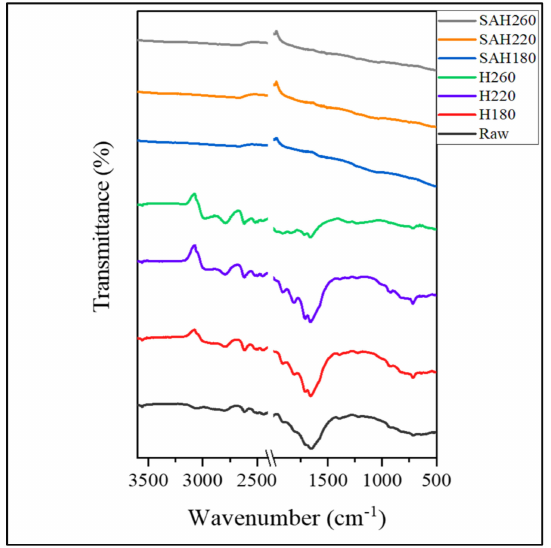
Figure 3. FT − IR spectra of loblolly pine biomass, hydrochars (H180, H220, H260) and corresponding activated hydrochars (SAH180, SAH220, SAH260).